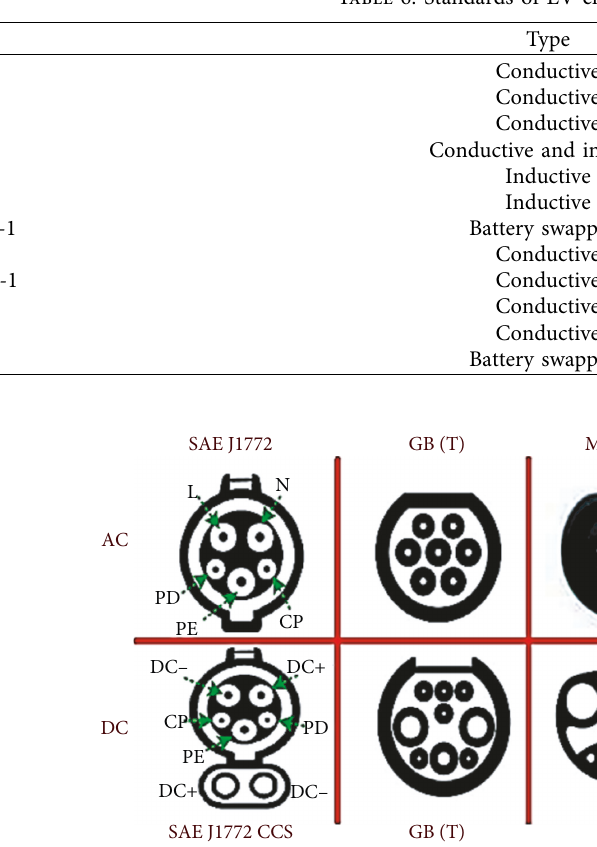
Figure 25: Various EV charging